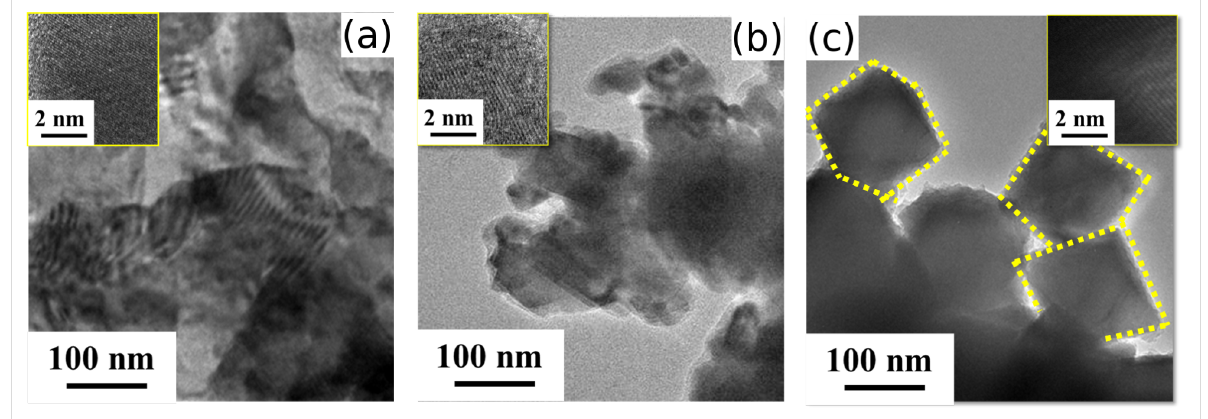
Figure 2: TEM Micrographs of (a) CISe nanocrystals, (b) CIGSe nanocrystals and (c) CZTSe nanocrystals. The insets depict HRTEM.